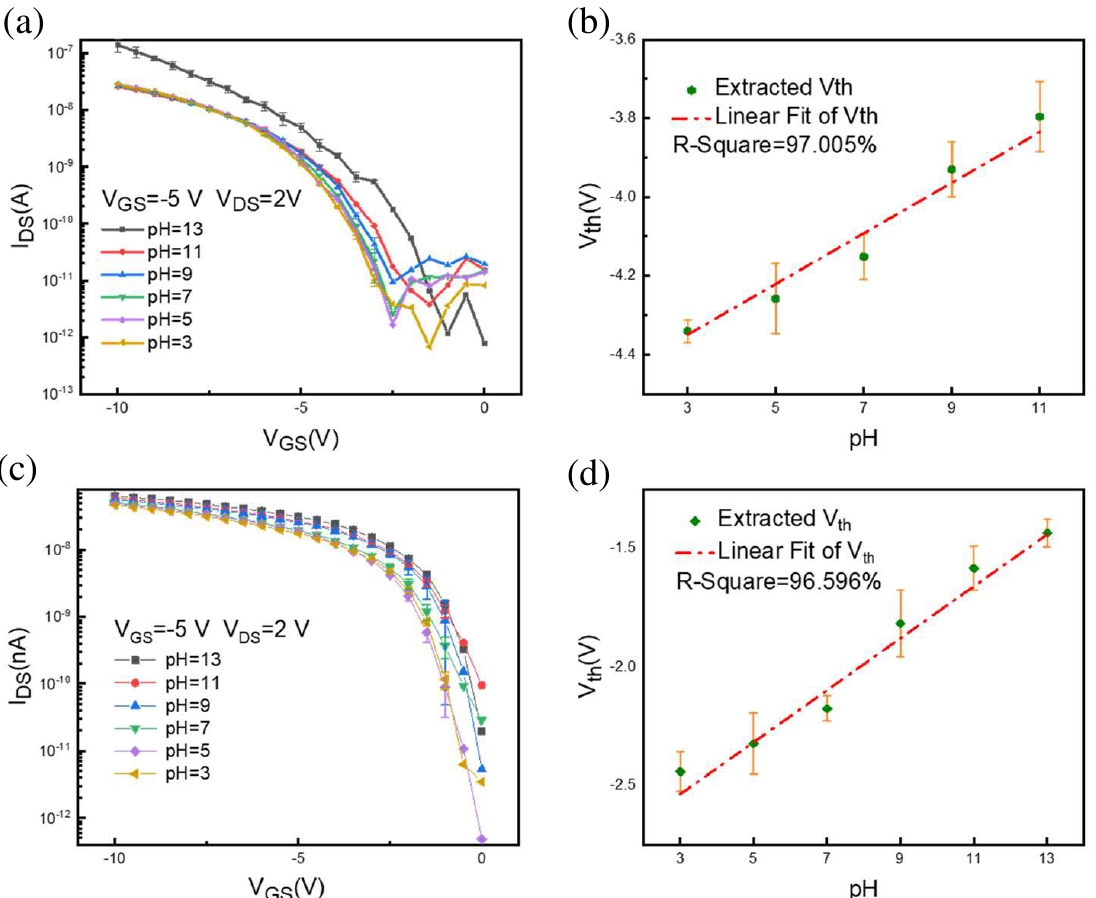
Figure 4. ( a ) Transfer characteristic curve (I DS –V GS ) of SiNW FET at different pH liquid gate environments (3–13), ( b ) extracted threshold voltage under different pH time-response curves of SiNW FETs. ( c ) Transfer characteristic curve (I DS –V GS ) of hydrogel-functionalized SiNW FET at different pH liquid gate environments (3–13), ( d ) dot plot of extracted threshold voltage under different pH time-response curves of hydrogel-functionalized SiNW FETs.